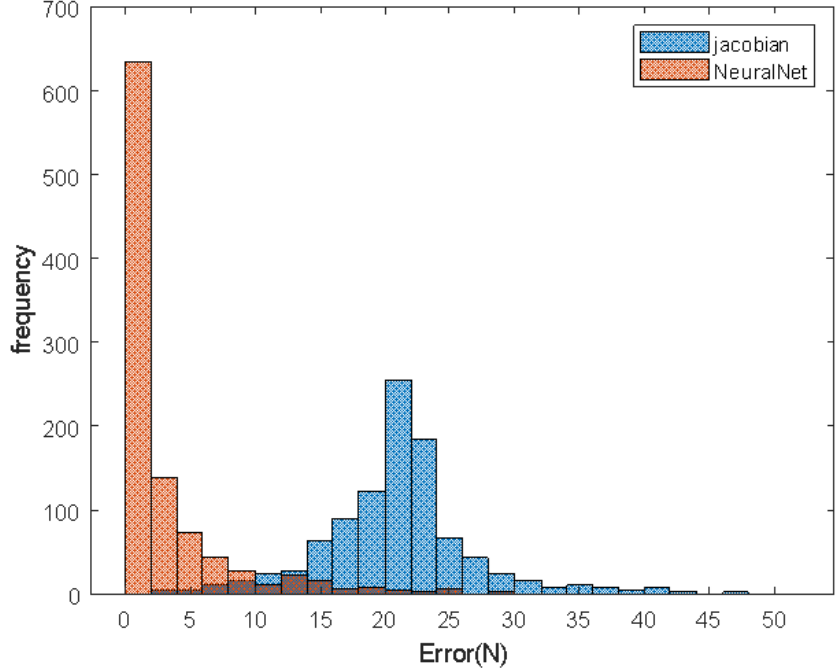
Figure 13. Histogram of force prediction